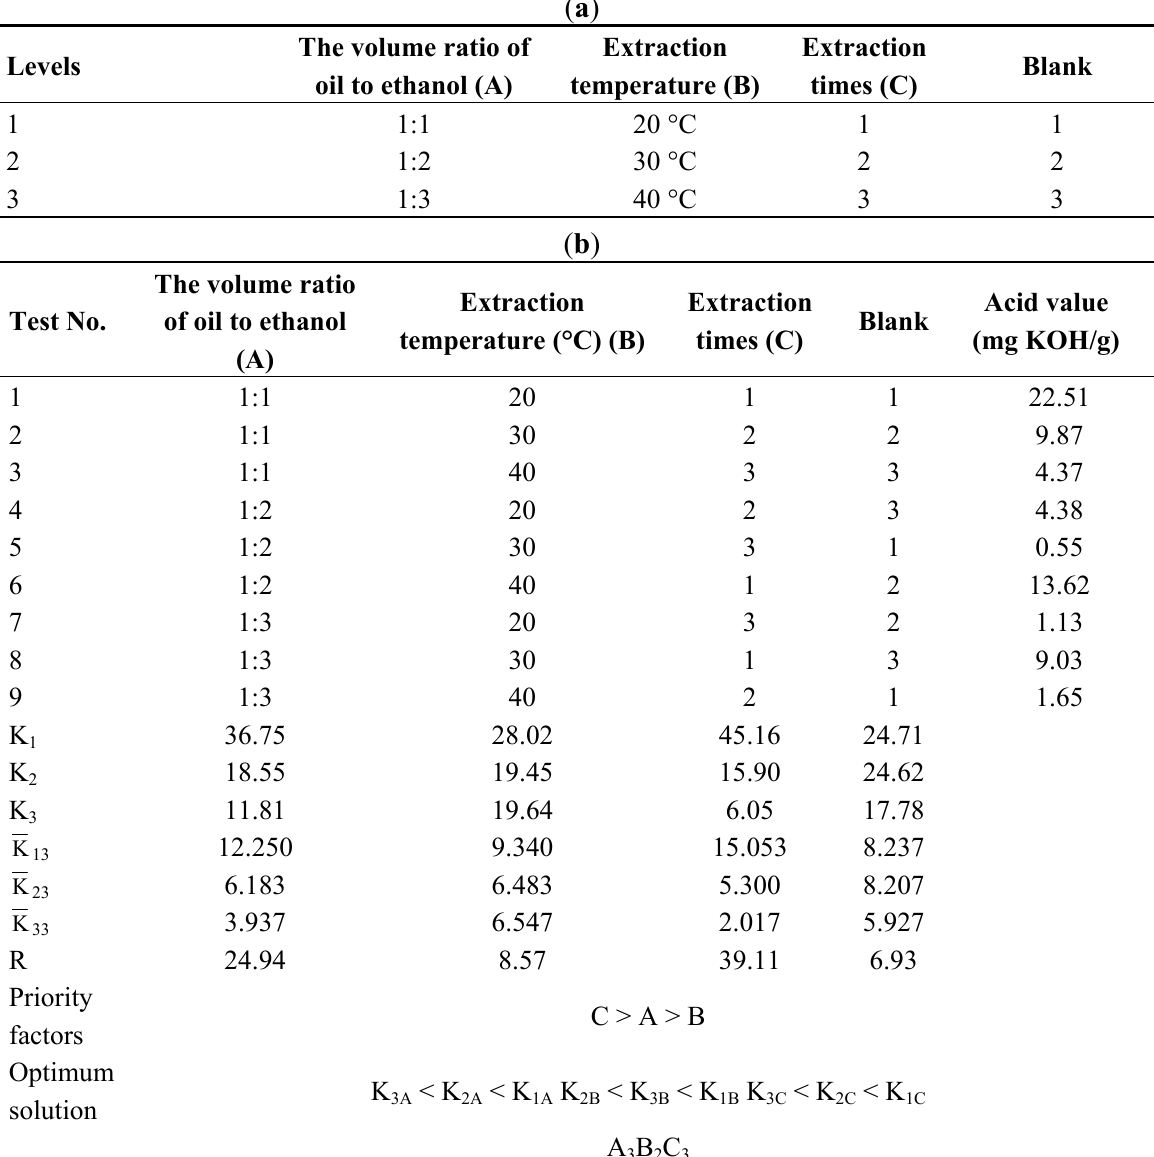
Table 3. ( a ) L (3 4 ) orthogonal experimental program of Pistacia chinensis oil 9 deacidification by ethanol; ( b ) Orthogonal experimental results of Pistacia chinensis oil deacidification by